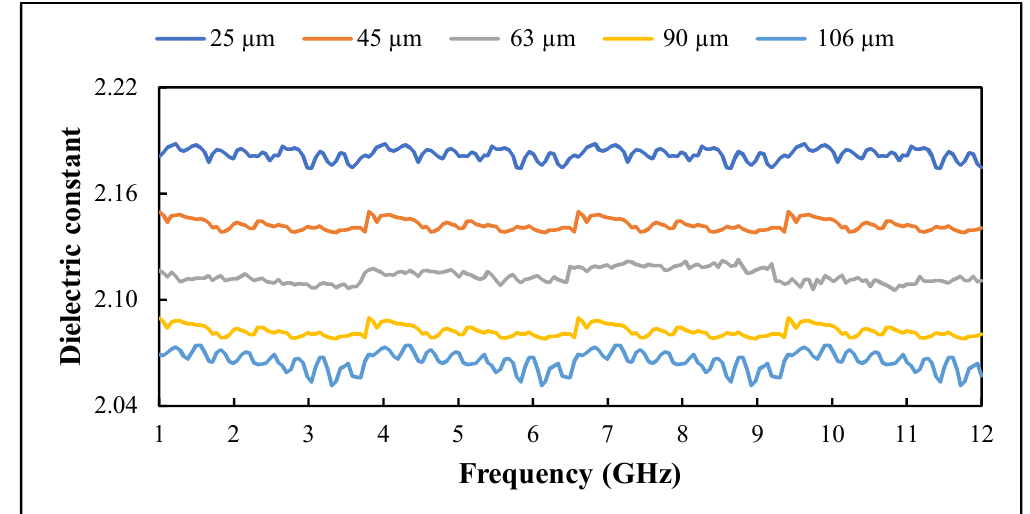
Figure 9. Variation of dielectric constant with filler size.